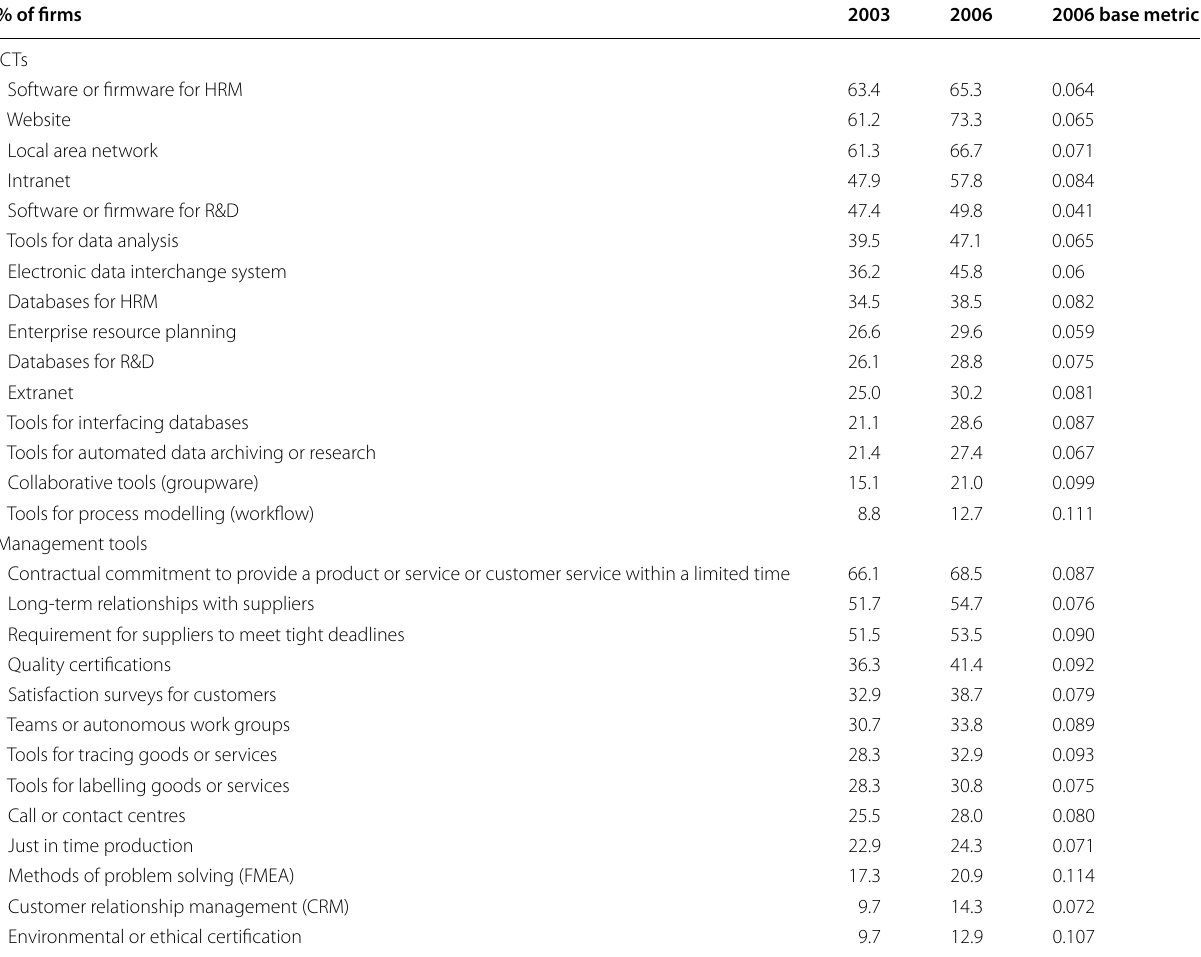
Table 1 Use of ICTs or management tools in 2003 and